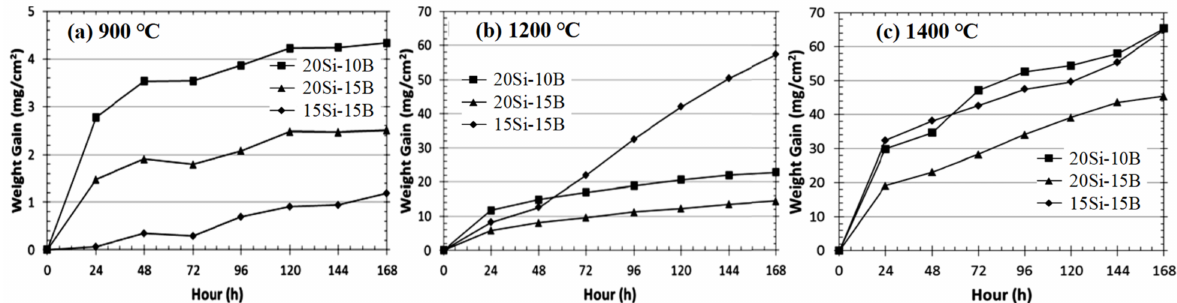
Figure 10. Cross-sectional BSE images of the Nb-22Ti-16Si-5Cr-4Hf-3Al-xB (x = 0 at.%, 2 at.%, 5 at.%) alloys after oxidation at 1250 ◦ C: ( a ) 0B, ( b ) 2B, and ( c ) 5B. Copyright 2014 Elsevier.